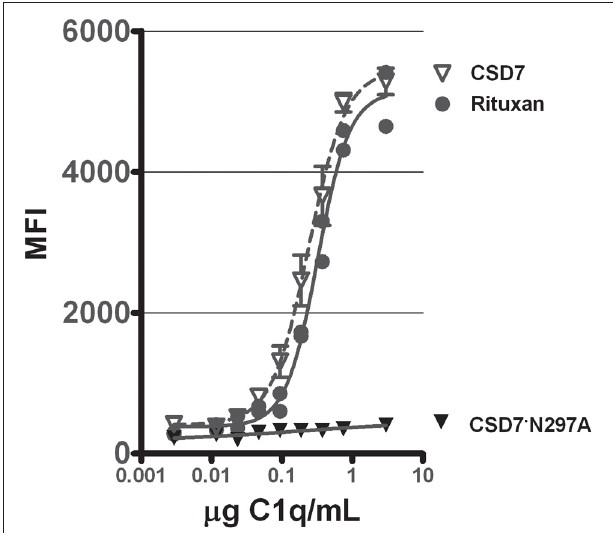
FIGURE 3 | Stimulation of complement C3b formation in human plasma by mAbs CS-D7, CS-D7 · N297A, or Rituxan © . Microtiter plates coated with one of three mAbs were exposed to C1q serially diluted into C1q deficient human sera. C3b generation was quantitated as described in Methods. Data shown are the mean ± s.e. n = 3.